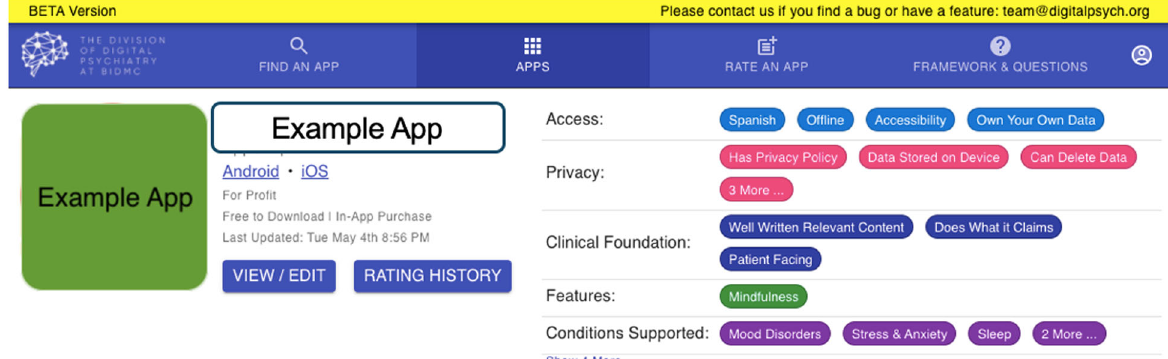
Fig. 4 Database List View. The app attributes are clearly depicted in list view, with users able to view app attributes across the APA